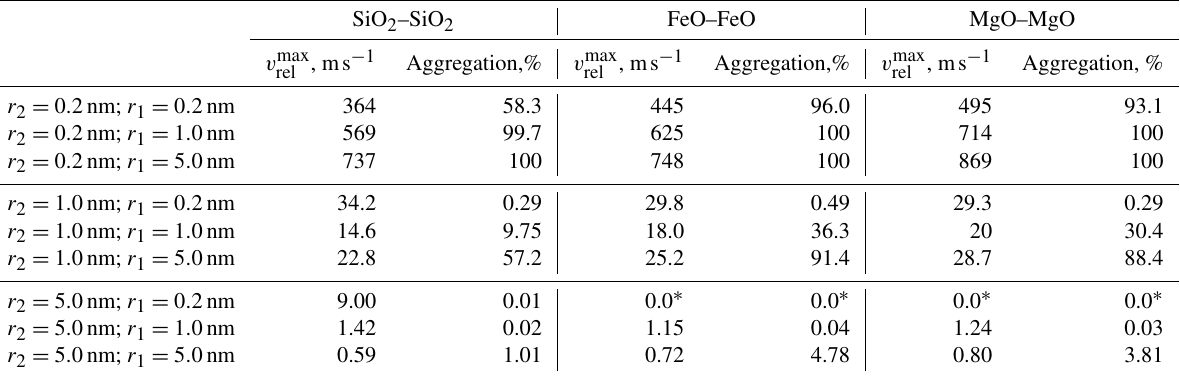
Table 4. Energetic considerations and the percentage of aggregation for SiO 2 –SiO 2 and FeO–FeO collisions at T = 150K and k r = 0 . 9 (the surface point charge model). Particle 2 has a fixed charge ( q 2 = − 1 e ), particle 1 is neutral ( q 1 = 0) and the size of both particles is varied. The collision geometry is shown in Fig.